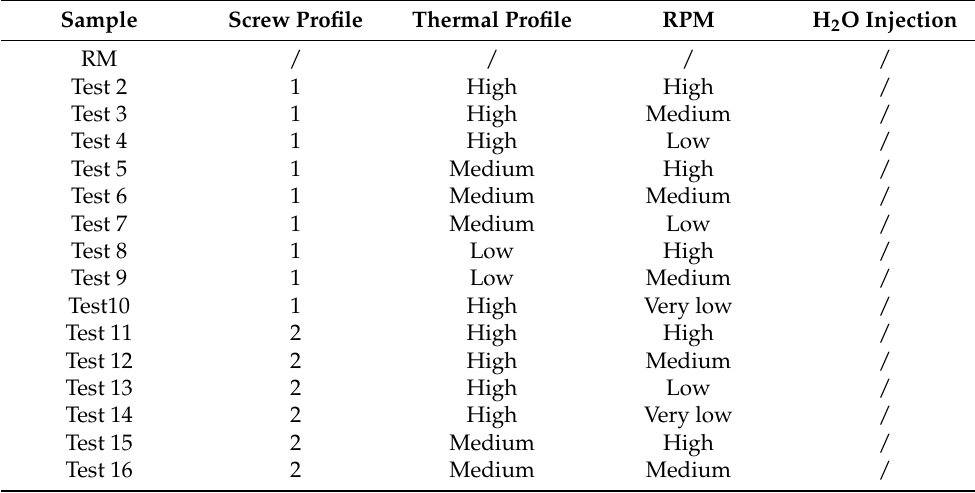
Table 1. Devulcanization conditions and samples. RM = raw material (feedstock). Sample